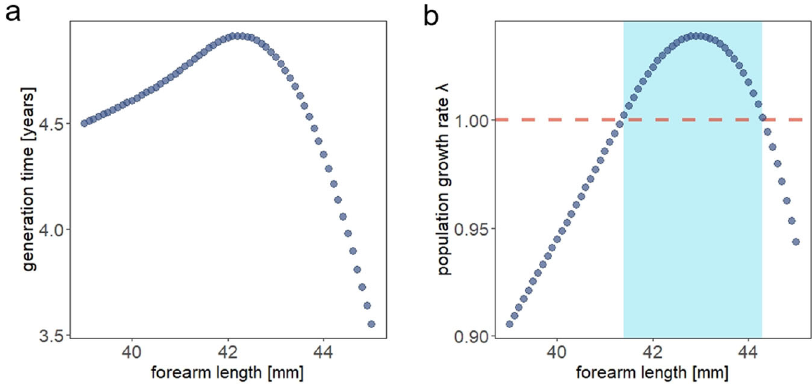
Fig. 5 The effects of body size on generation times and population growth rate. Predicted response of ( a ) generation time and ( b ) population growth rate in dependence of body size (forearm length (mm)). The highlighted blue area marks the size range, where population growth is predicted to occur. All underlying GAMs are calculated with k = 10, Gamma = 1.4 and method